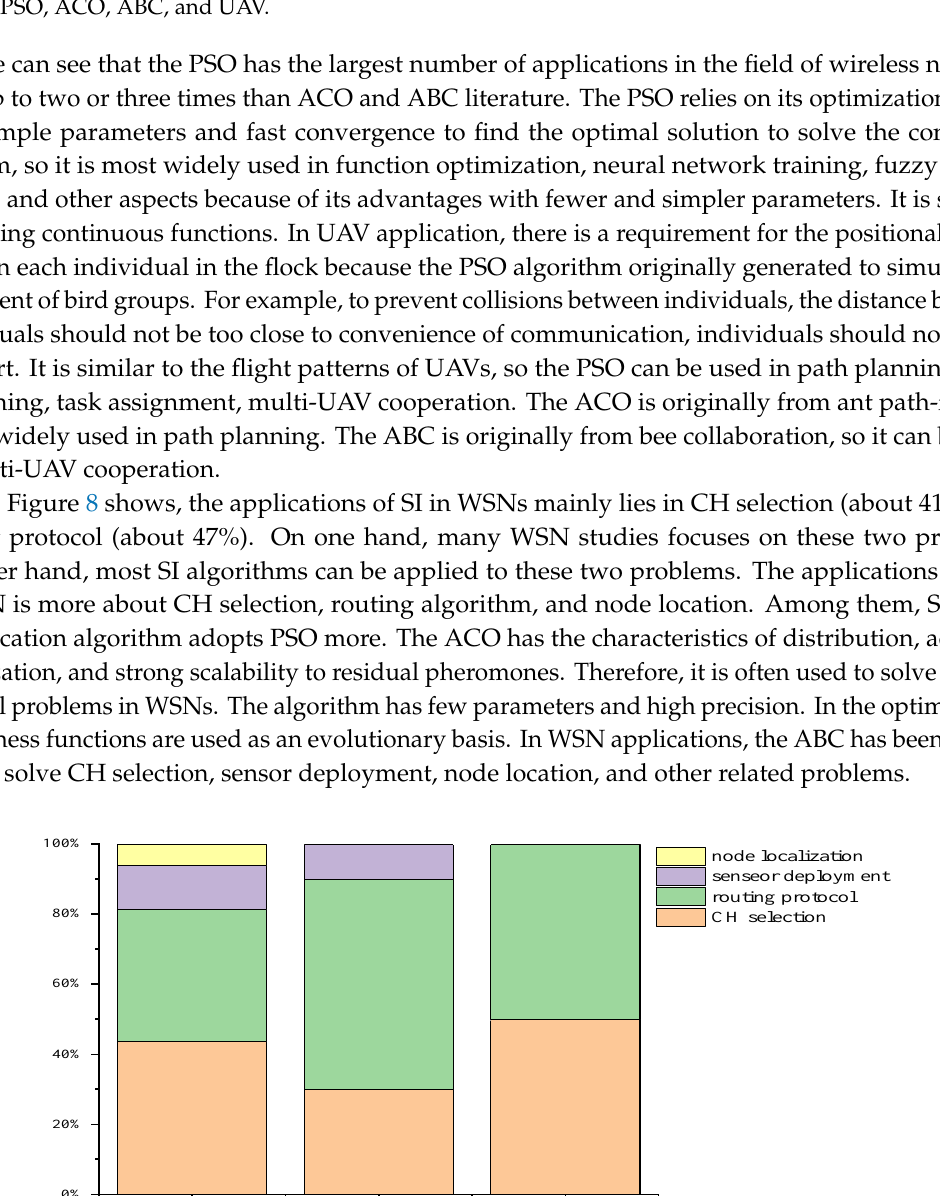
Figure 9. SI algorithm optimization methods. 7.2. Development Trend